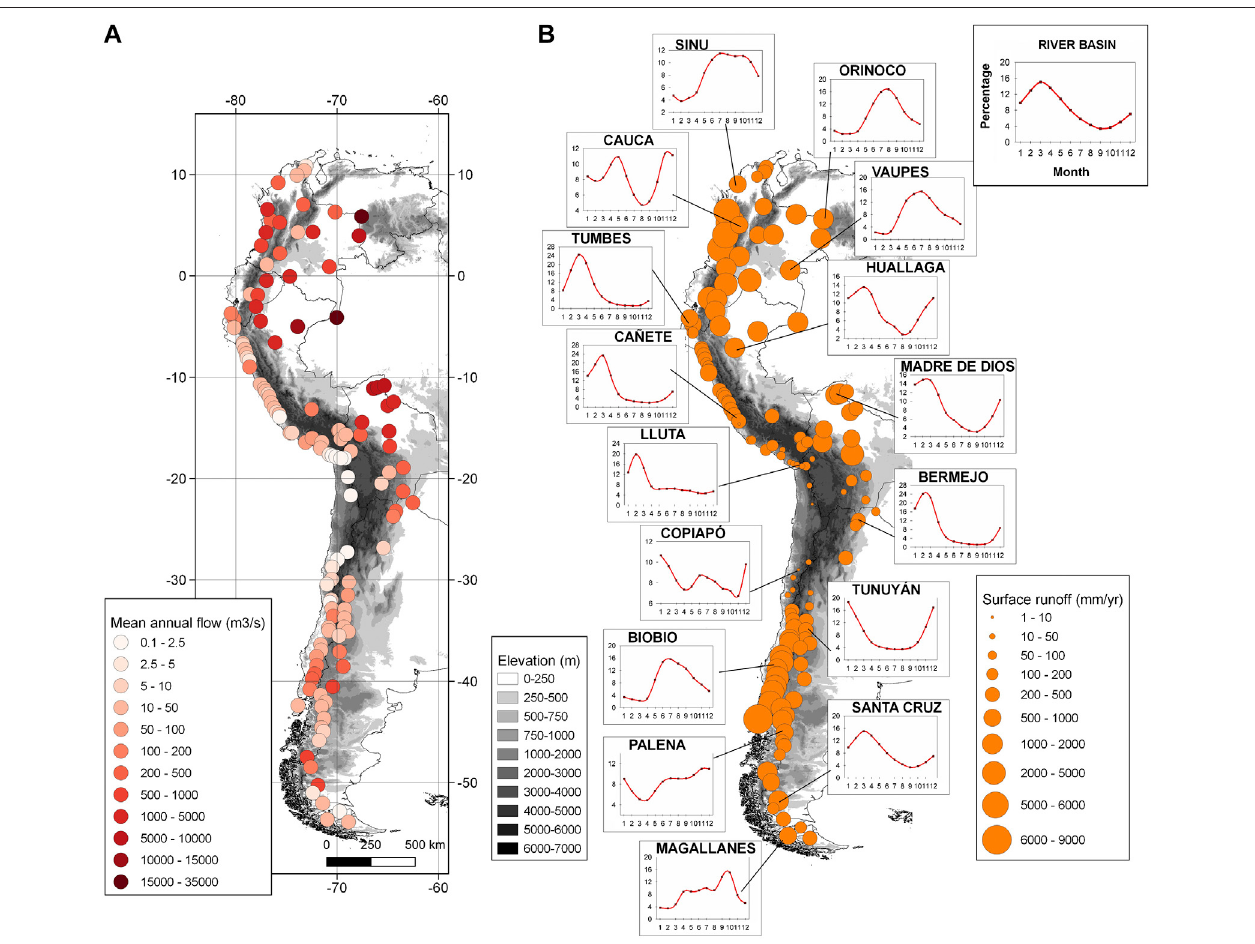
FIGURE 1 | (A) Mean annual stream fl ow for selected rivers along the Andes. (B) Mean annual surface runoff of the same selected rivers. The annual cycles (expressedasmonthlypercentagesrelativetotheannualtotals)arealsoshownforcharacteristicriverbasinstoillustratethemarkedcontraststhatexistalongtheAndes. NotethatthesediagramshavedifferentY-axisscalestohighlightthecharacteristicseasonalvariabilityateachsite.X-axisindicatesthemonthoftheyear(from1:January to 12: December). Also note that as the period of records can vary among stations ( Table 1 ), the values in the fi gure only provide an overall indication of the long- term mean annual and monthly conditions at each site.